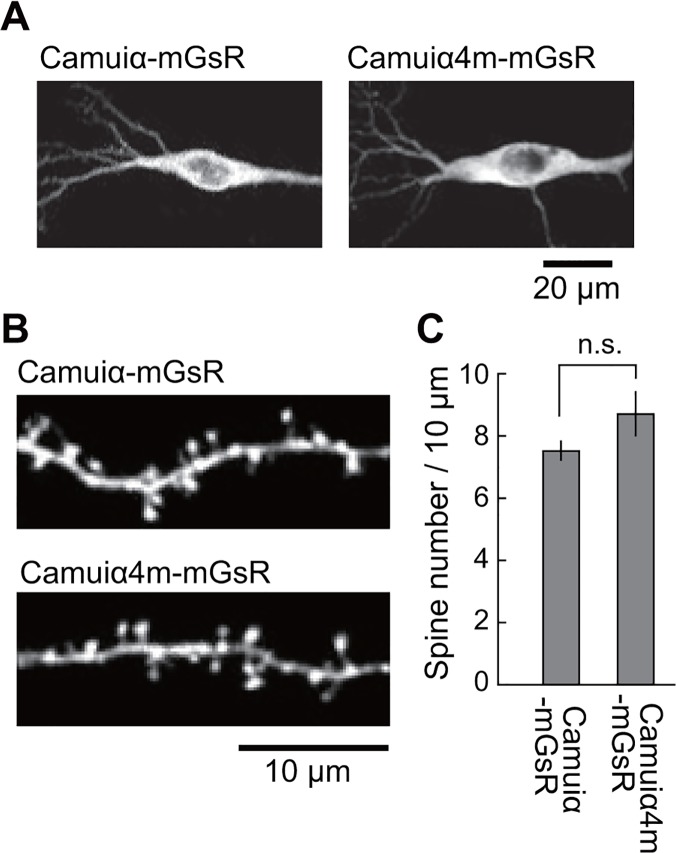
Two-photon fluorescence images of the neurons expressing Camuiα4 mutants in hippocampal slice culture.
(A) Representative images of soma of the CA1 pyramidal neuron expressing Camuiα-mGsR or Camuiα4m-mGsR. Either Camuiα-mGsR or Camuiα4m-mGsR was transfected using a gene gun, and 2 days after transfection, cells were imaged with a 2-photon fluorescence microscope. Scale bar = 20 μm. (B) Representative images of apical dendrites from CA1 pyramidal neurons expressing Camuiα-mGsR or Camuiα4m-mGsR. Scale bar = 10 μm. (C) Spine density in apical dendrites of neurons. The numbers of samples (spines/neurons) are 1541/7 for Camuiα-mGsR and 1827/7 for Camuiα4m-mGsR. There were no significant differences between the spine density in neurons expressing Camuiα and Camuiα4m (p > 0.05, t-test, n.s., not significant). Error bars indicate S.E.M.